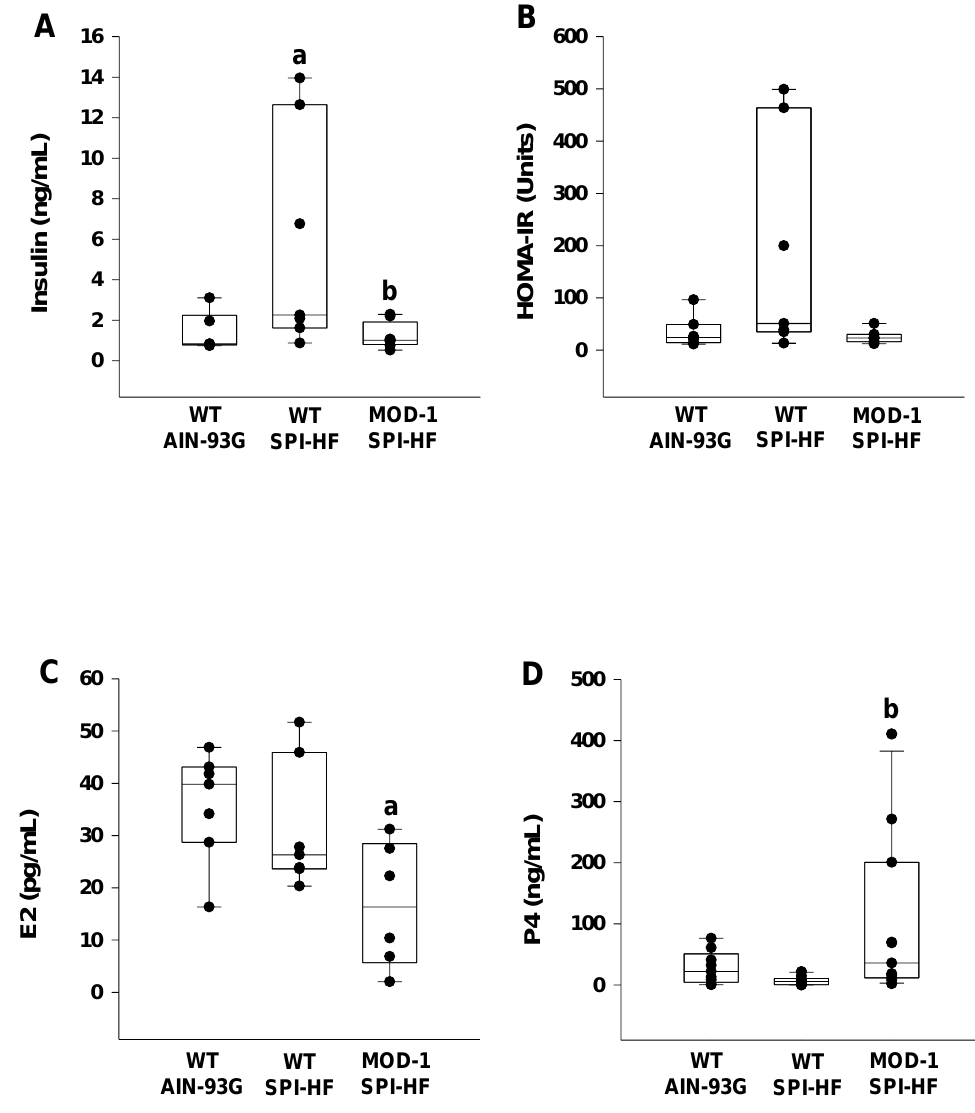
Figure 4. Serum ( A ) insulin, ( B ) HOMA-IR, ( C ) estradiol-17 β (E2), and ( D ) progesterone (P4) values for experimental mice ( n = 7 WT AIN-93G; n = 7 WT SPI-HF; n = 6 MOD-1 SPI-HF). Box plots indicate the upper and lower quartiles, interquartile range, and median (middle line), with whiskers showing maximum and minimum points within 1.5 × the interquartile range. Significant differences are indicated by a and b; a indicates p < 0.05 compared to the WT AIN-93G group and b indicates p < 0.05 for WT SPI-HF vs. MOD-1 SPI-HF